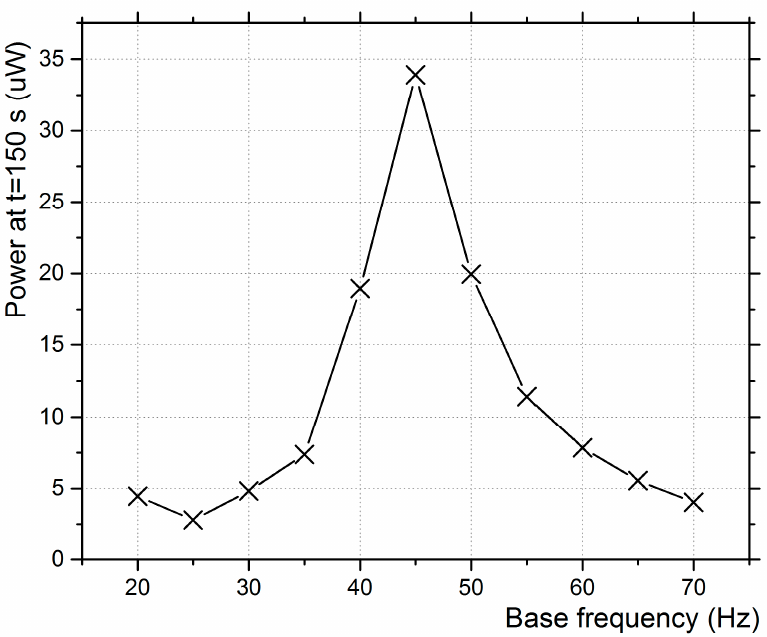
Figure 8. Power stored after 150 s vs. base frequency (only base excitation).